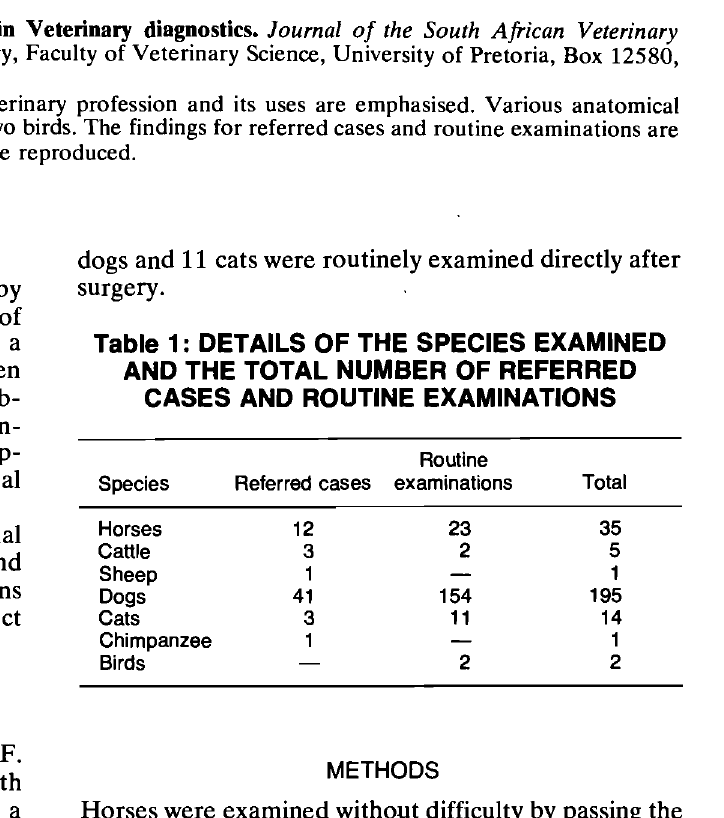
Table 2: THE VARIOUS ANATOMICAL STRUCTURES EXAMINED IN EACH SPECIES